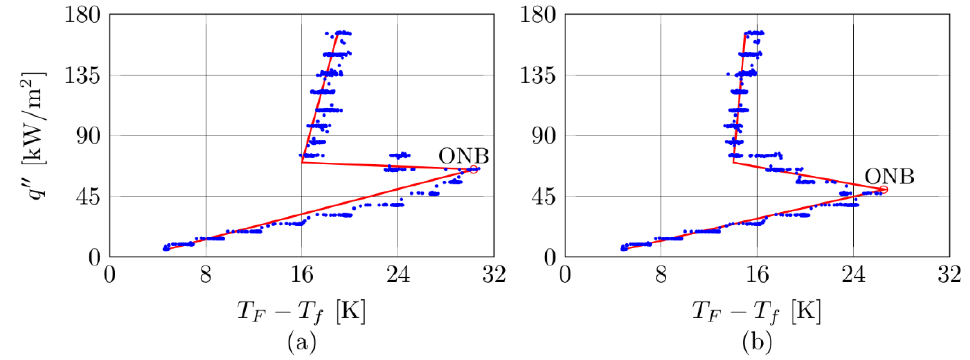
Figure 16. Boiling curves constructed for: ( a ) 0.015 m and ( b ) 0.025 m distances from the minichannel inlet, based on the data for the test section with five minichannels, experimental parameters shown in Table 2.